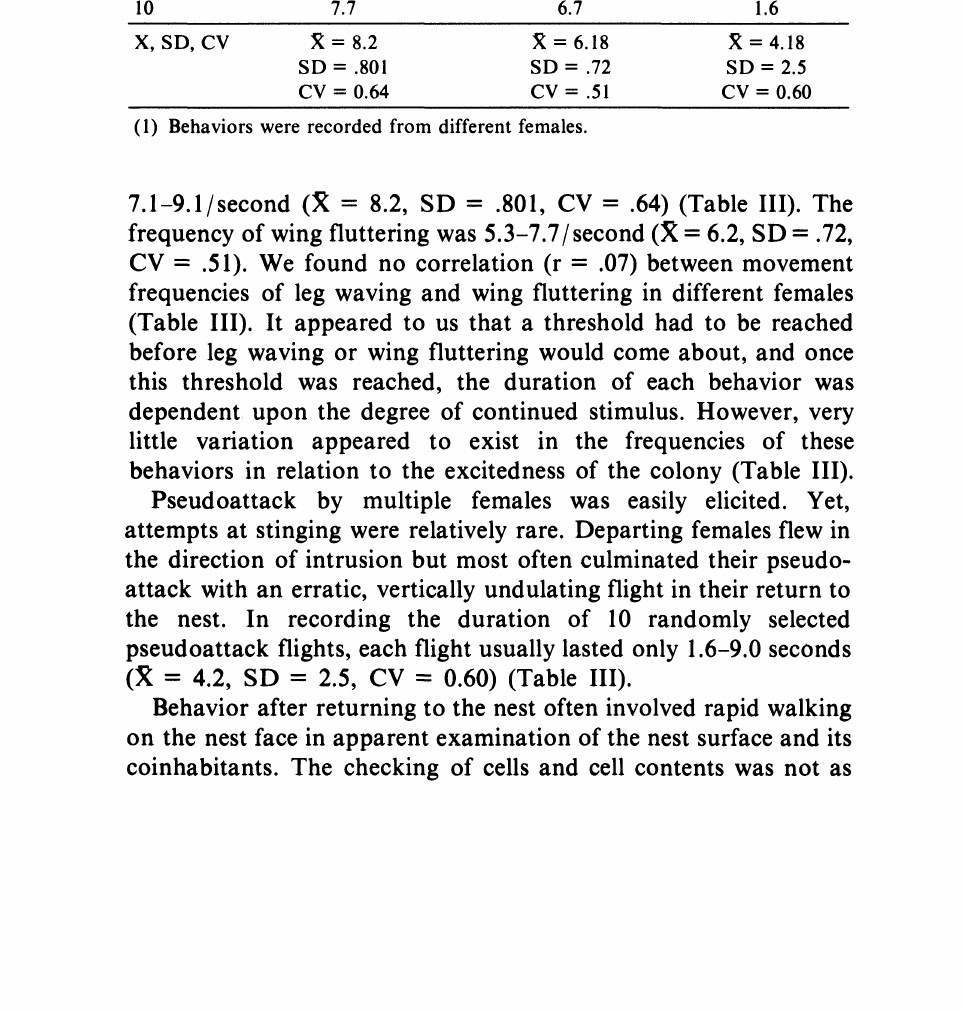
Psyche [Vol. 91 Table Ill. Statistical Analysis of Frequencies of Readily Expressed Warning Behaviors in Colonies of M. m. cubicola (l) Pseudoattack Exp. Leg Waving Wing Fluttering Flight Time # Movements/Sec.